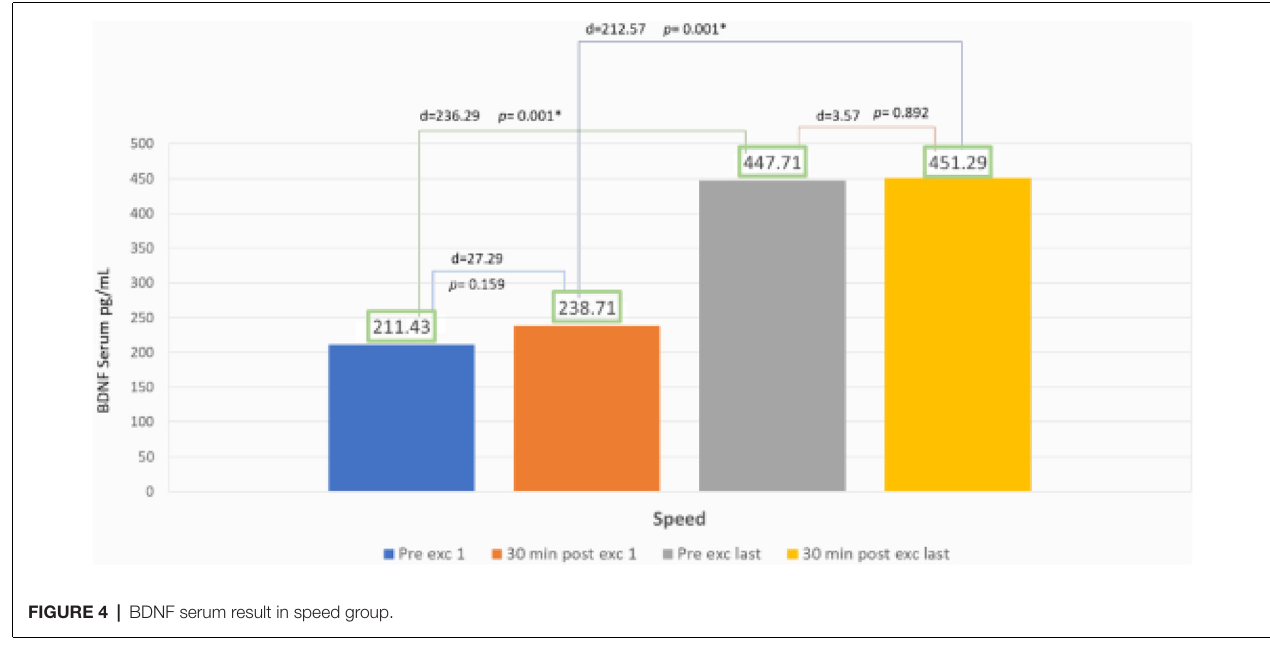
changes of the first day in speed group ( p =